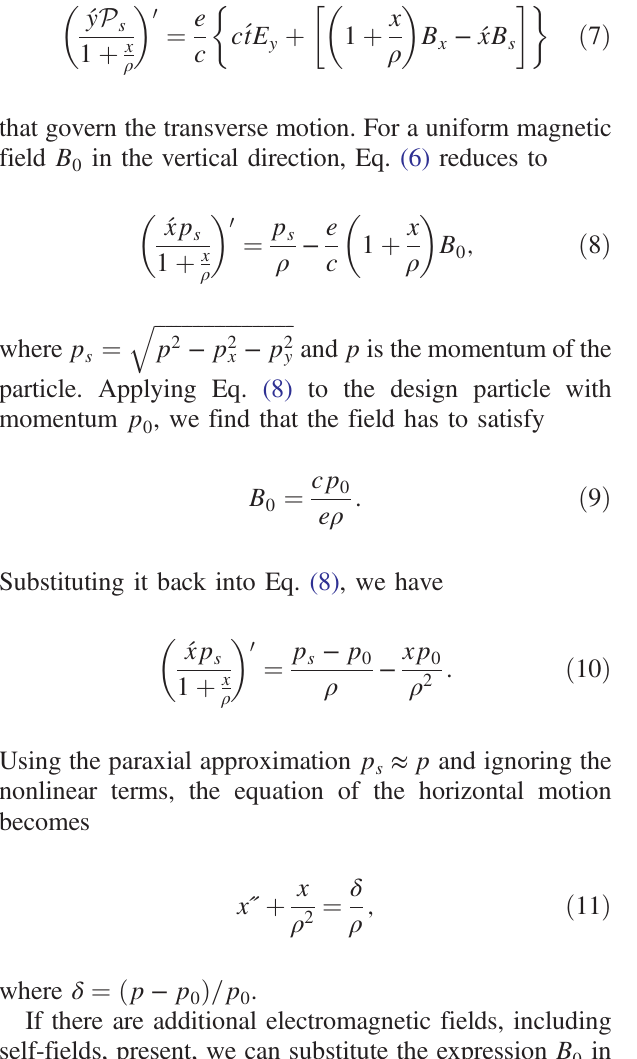
FIG. 2. A source particle (at A) moves along a circular orbit and radiates electromagnetic fields that reach a testing particle (at